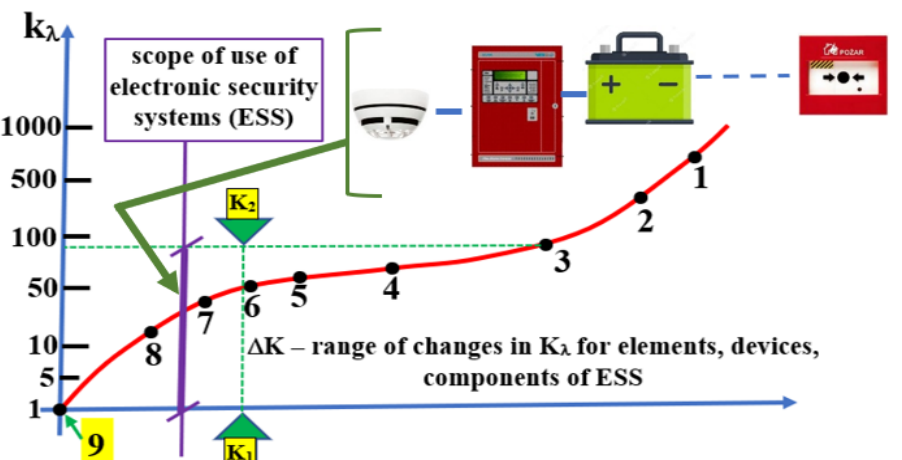
Figure 7. Change of the k λ damage intensity coefficient for FAS elements, modules and components